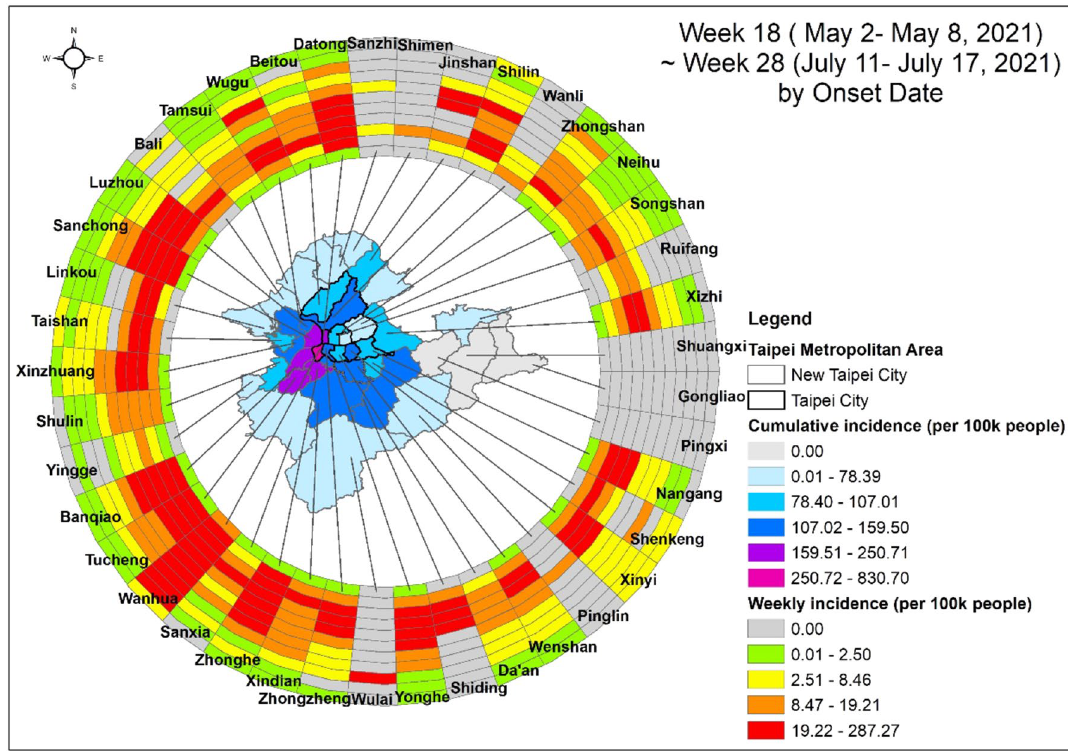
Figure 2. Spatiotemporal dynamics of COVID-19 incidence at the district level in Taipei and New Taipei City from week 18 to week 28, 2021. The map was created by ArcGIS (ArcMap, version10.3; ESRI Inc., Redlands, CA, USA) and the ring map was created by the ring map toolbox in ArcGIS (https:// www. esri. com/ about/ newsr oom/ arcus er/ looki ng- at- tempo ral- chang es).